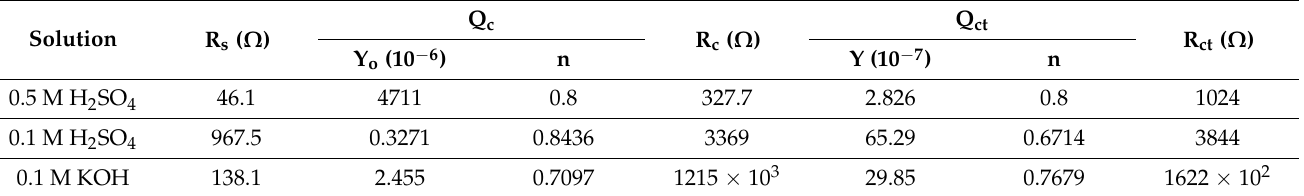
Table 1. Parameters obtained by fitting EIS data with R(QR)(QR) equivalent